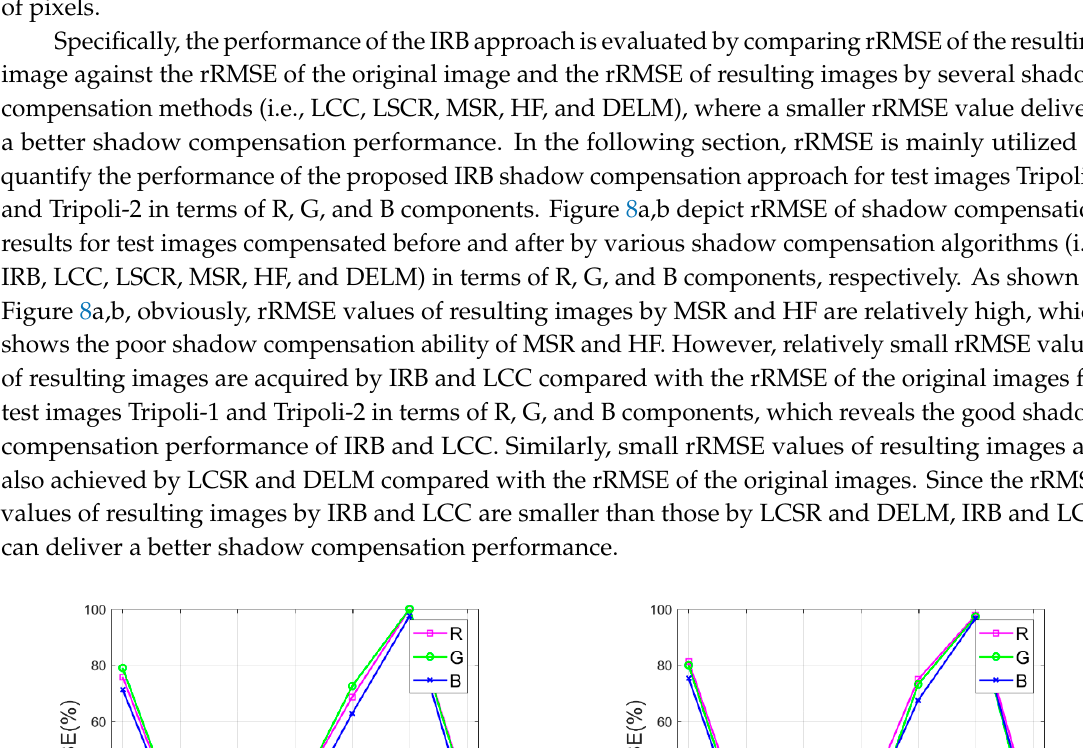
( b ) Figure 9. ∆ r RMSE between non-shadow regions in the original image and those in the shadow compensation resulting images by various shadow compensation algorithms for test images in terms of R, G, and B components. ( a ) Tripoli-1. ( b ) Tripoli-2. Generally speaking, the proposed IRB method not only further alleviates the color distortion problem compared with typical image enhancement based shadow compensation methods (like MSR and HF), but also acquires a relatively good visual sense similar to that by LCC. Besides, the relatively small rRMSE and zero or approximately zero ∆ RMSE also reveal the relatively good performance of the proposed IRB method for shadow compensation and non-shadow preservation. Better agreement is also shown for R,G, and B components of results in terms of both visual sense and quantitative measurement (rRMSE) by the proposed IRB method against the compared methods.